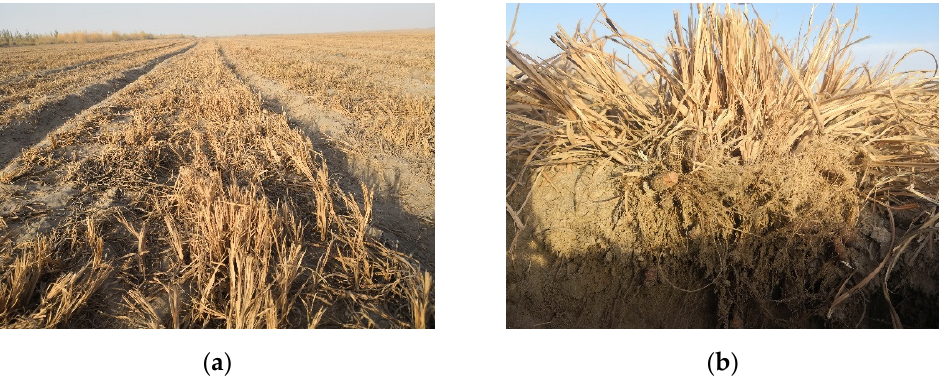
Figure 9. Cyperus esculentus planting base. ( a ) Uncultivated land; ( b ) section of the Cyperus esculentus plant.